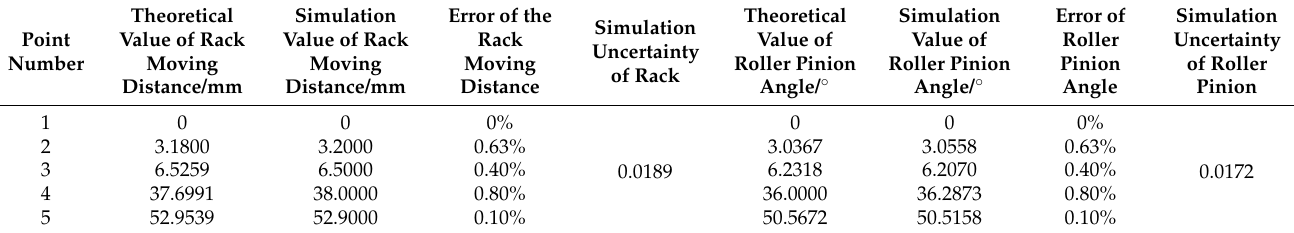
Table 3. Simulation errors of the line of action.